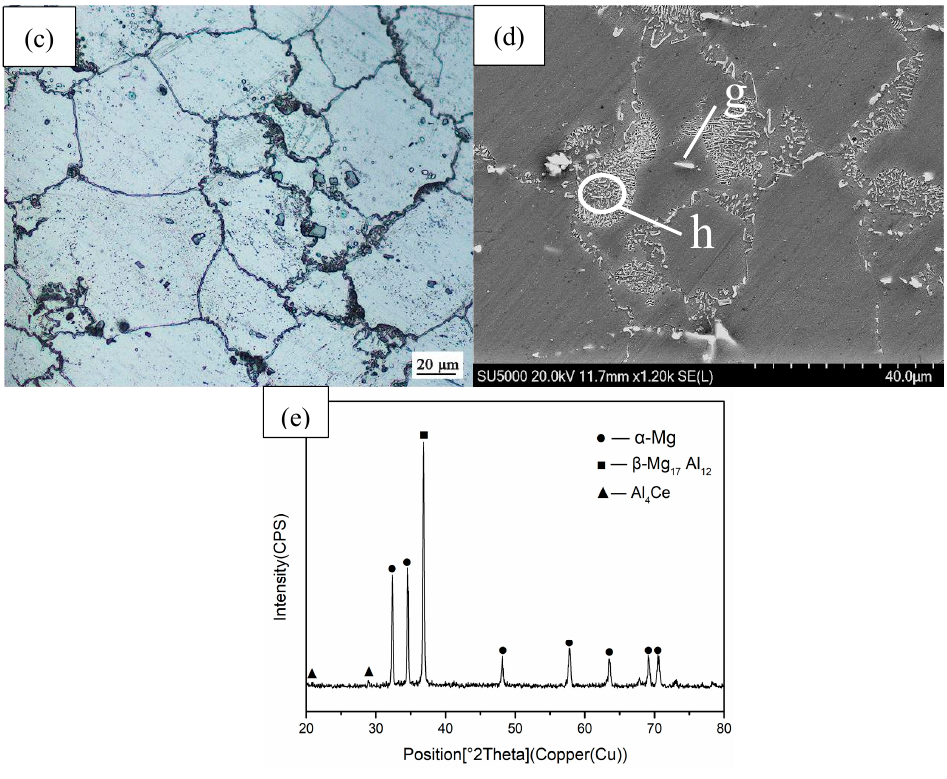
Figure 5. Microstructure of original extruded bar observed by OM and SEM: ( a ) OM with 200× magnification, ( b ) OM with 500× magnification, ( c ) SEM with 400× magnification, ( d ) SEM with 1200× magnification, ( e ) XRD pattern of the original extruded alloy. Table 3. EDS results with the element atomic percentage of points in Figure 6b,d (at %).